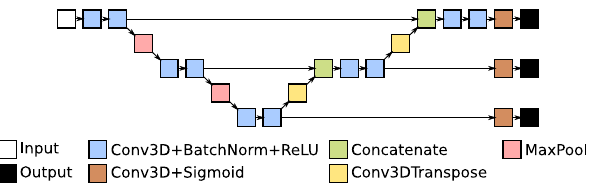
Figure 3. Three multi-scale layer U-Net with Deep Supervision. Additional outputs are introduced at lower